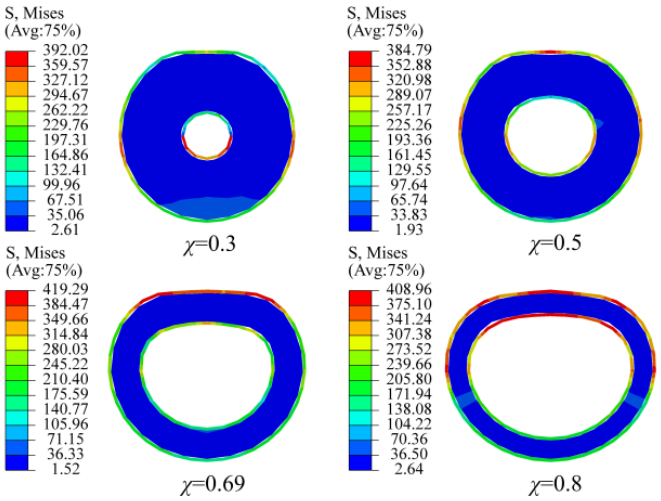
Figure 8. Failure pattern of the cross section.